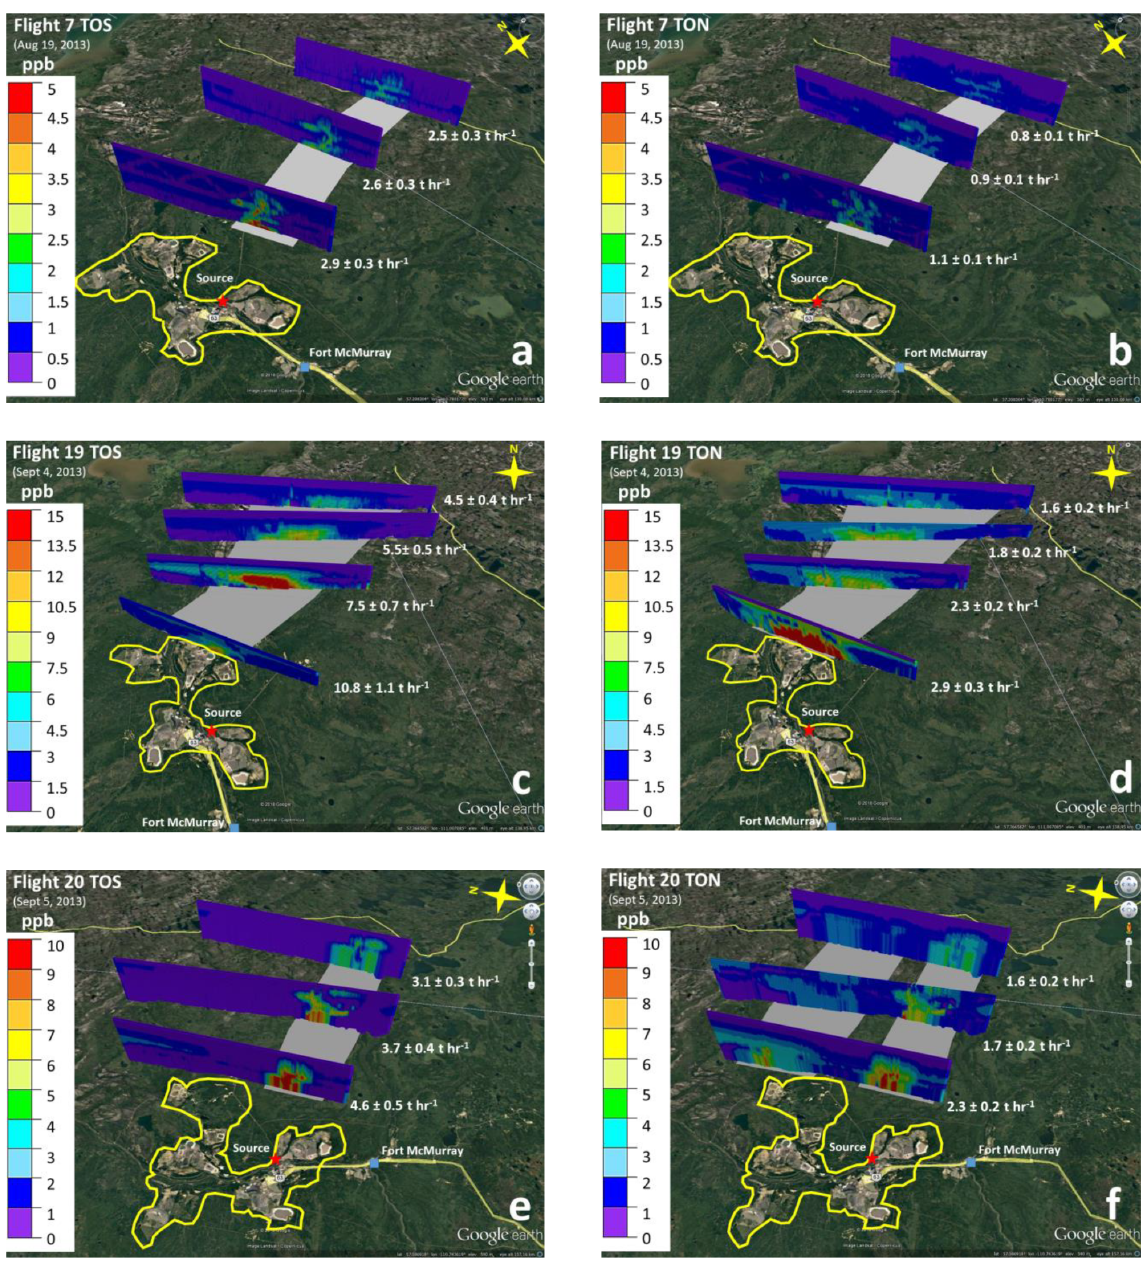
Figure 1. TOS (total oxidized sulfur) and TON (total oxidized nitrogen) plumes downwind of the AOSR during three Lagrangian flights, F7, F19 and F20. The AOSR facilities are enclosed by the yellow outline. The transfer rates T in tS or Nh − 1 across each screen are shown. The grey-shaded surface areas are identified as the geographic footprint under the plumes. Data: Google Image © 2018 Image